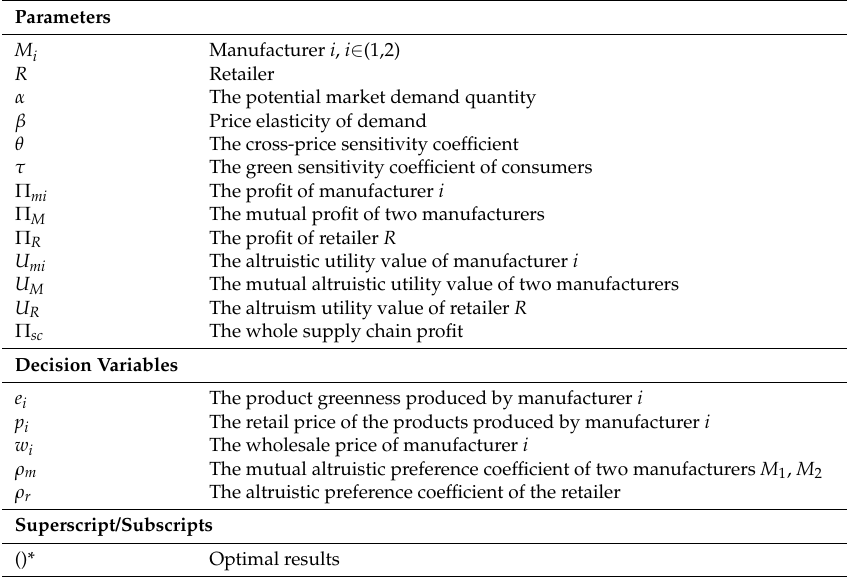
Table 1. The notations in the cooperative supply chain decision models.